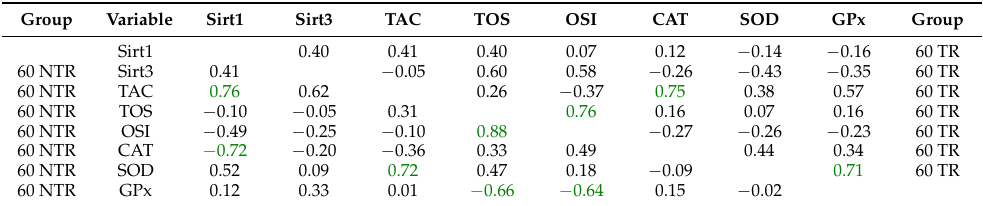
Table 5. Correlations between the concentrations of sirtuins and prooxidative–antioxidant balance markers in older training and non-training